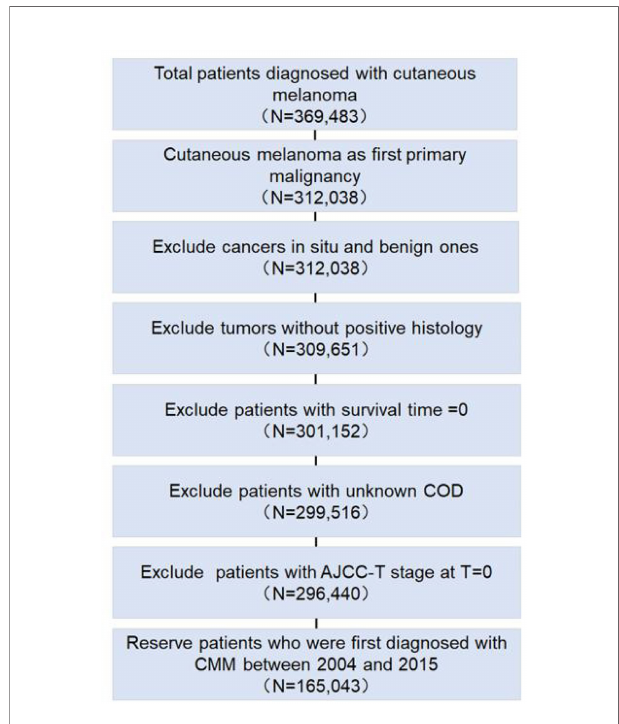
FIGURE 1 | Flowchart for exclusion criteria of the clinical cohort. The number of reserved patients is demonstrated in the fl